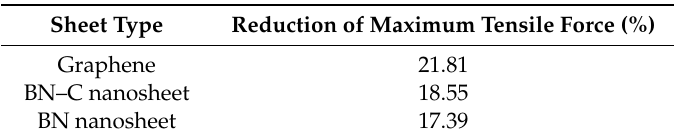
Figure 10. Tensile loading characteristics of the BN–C / PE nanocomposites at various temperatures. The carbon concentration of the nanosheet reinforcement is described in the figure legend. Table 2. Percentage reduction of the maximum tensile force of the BN–C nanosheet with defects when the temperature is increased from 300 K to 900